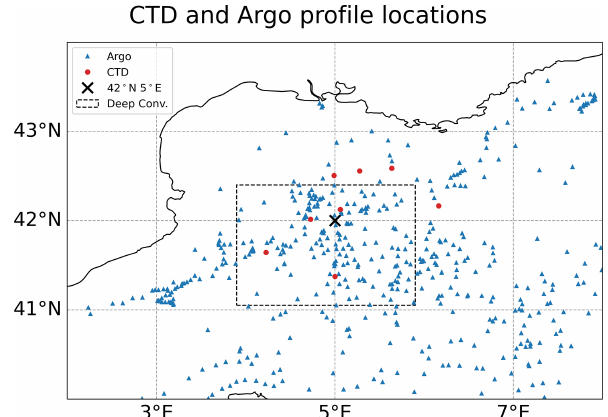
Figure 4. Locations of the CTD and Argo profiles. The red circles represent the CTD locations, and the blue triangles represent the Argo float profile locations. The deep-convection area is marked by the box with a dashed perimeter and 42 ◦ N, 5 ◦ E is marked by a